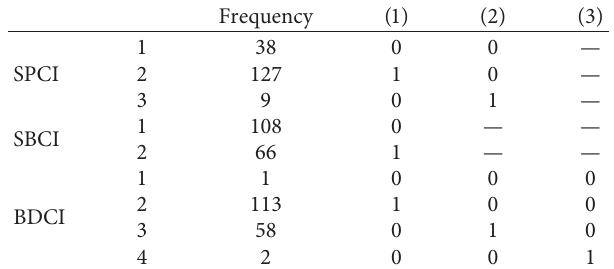
Table 8: Categorical variable coding.